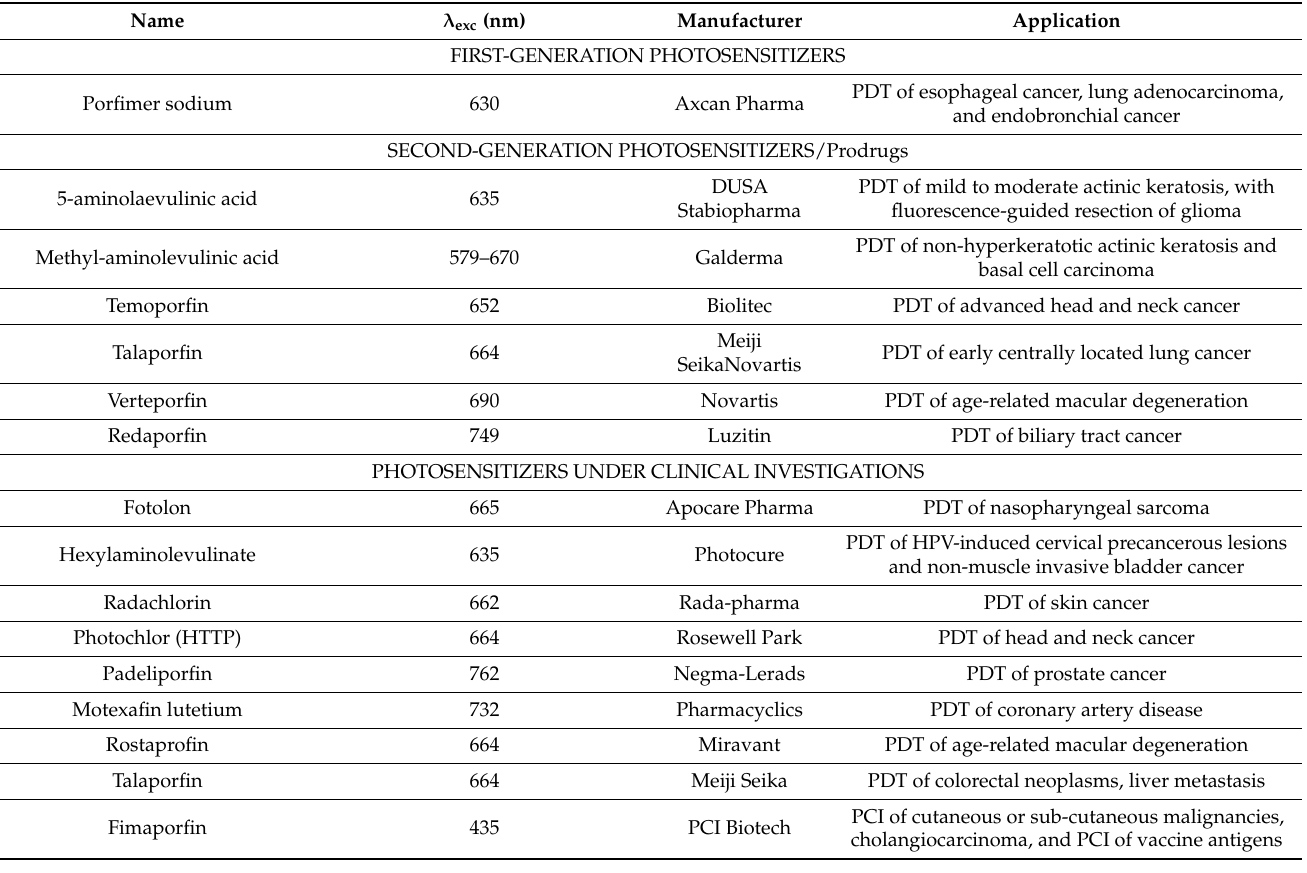
Table 2. Photosensitizers approved or under clinical trials [150]. A more detailed table can be found in the Supplemental Material, Table